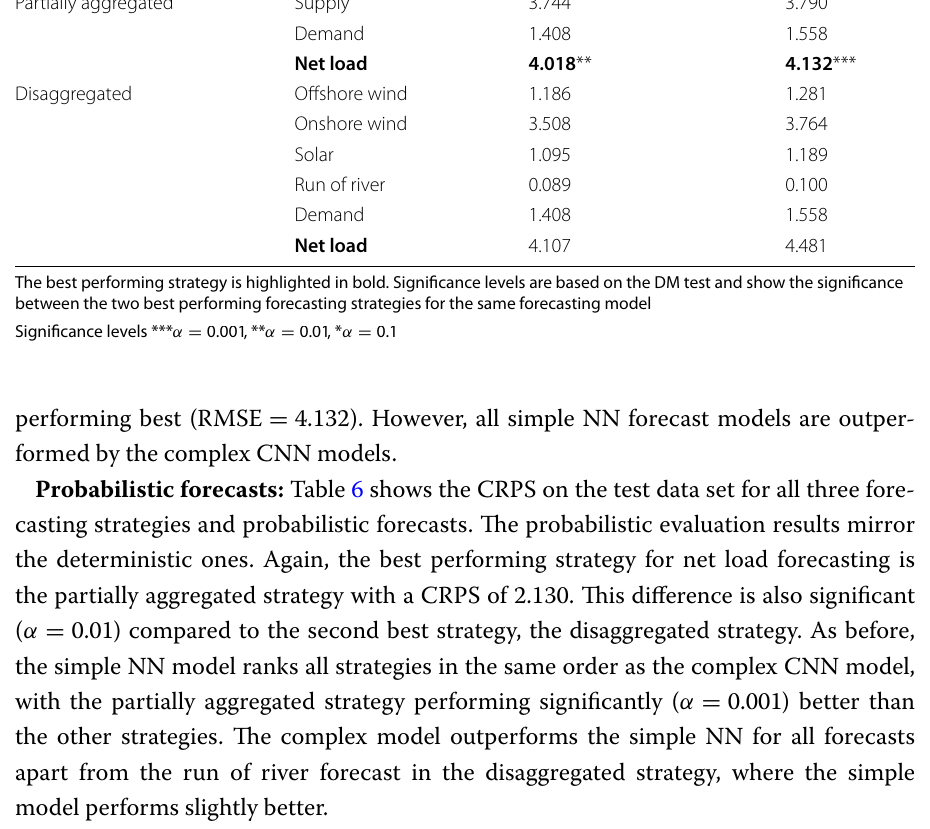
Table 5 RMSE calculated on the test set for the different deterministic forecasting strategies